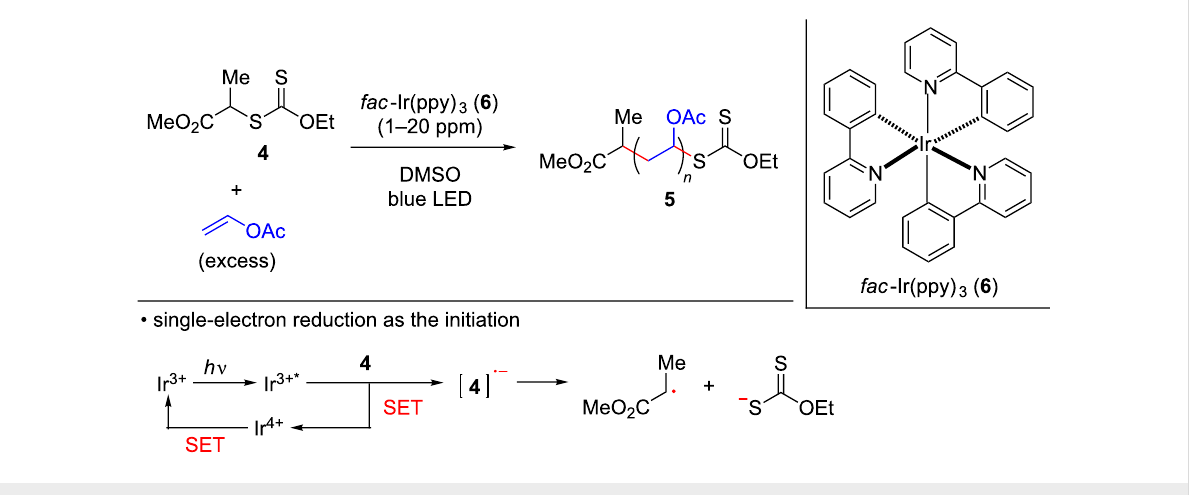
Scheme 2: Photocatalytic RAFT polymerization of xanthate 4 .